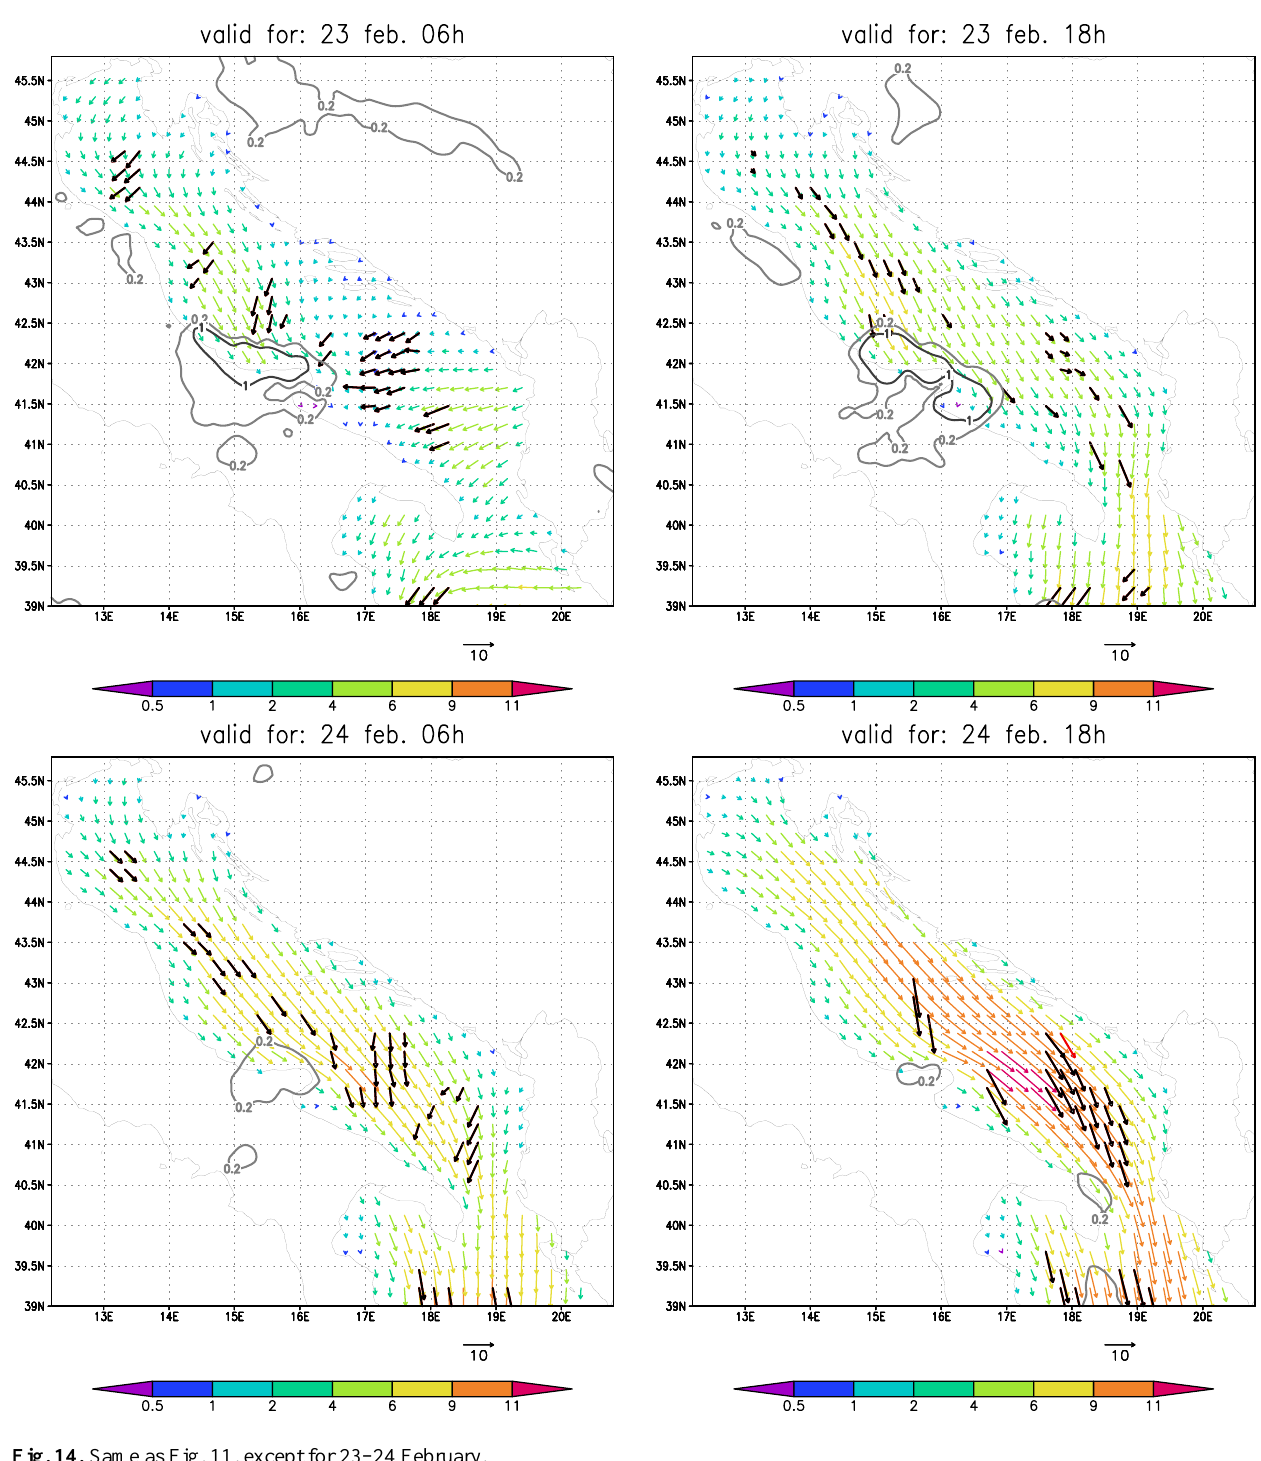
Fig. 14. Same as Fig. 11, except for 23–24